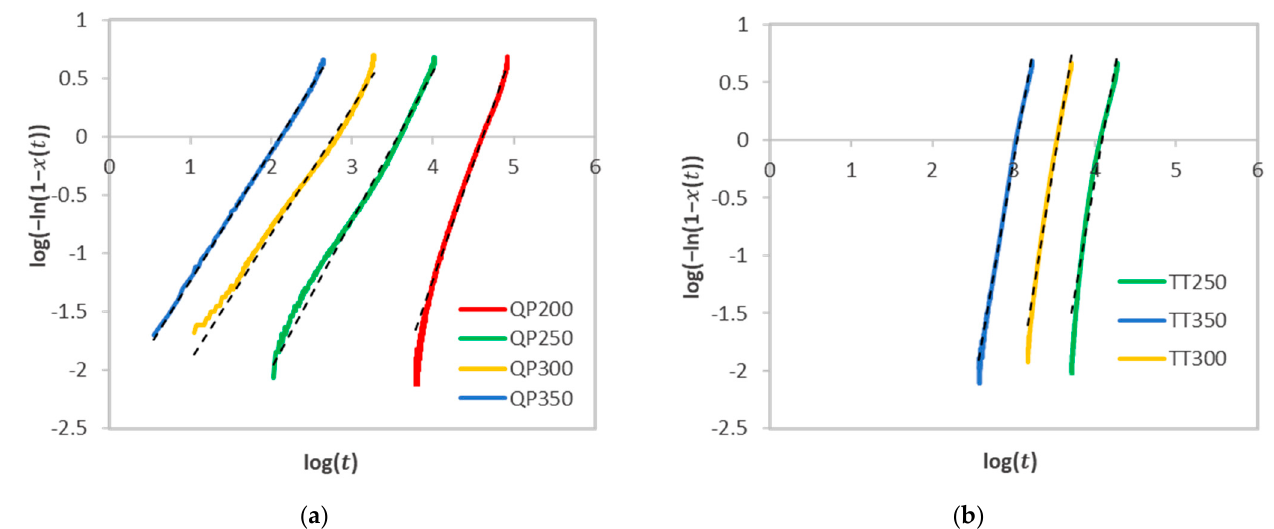
Figure 5. Linear fitting of log ( − ln (1 − x(t)) and log(t): ( a ) QP ( b ) TT. Table 3. Summary of the Avrami constants n and K for high-carbon